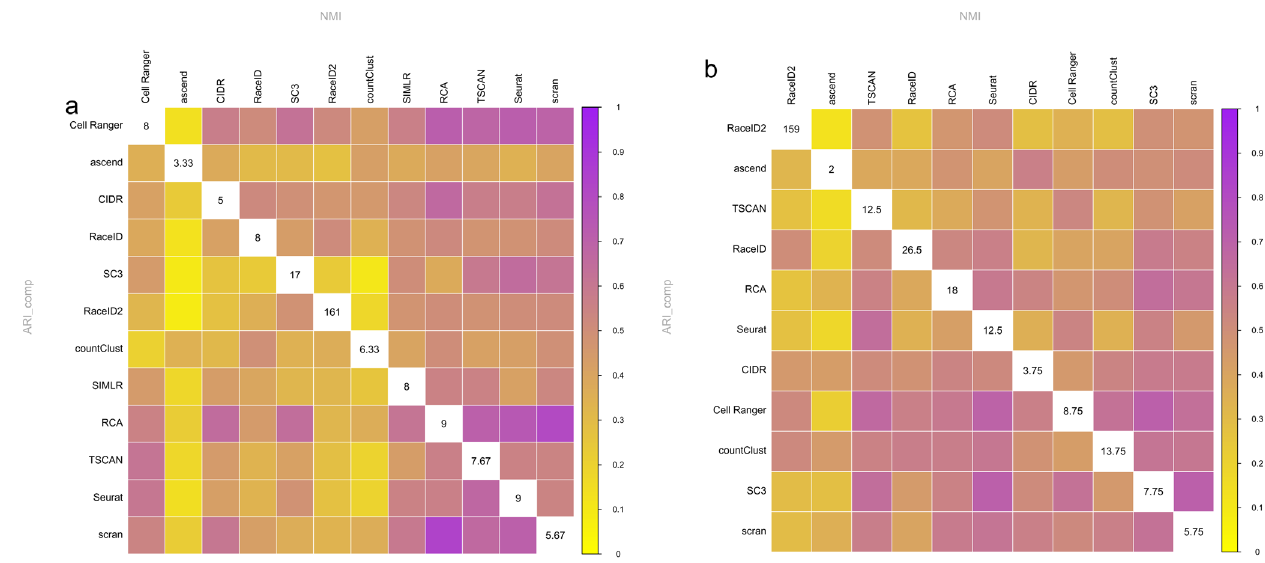
Figure 4. Similarity of all combinations of clustering methods as estimated by ARI_comp (lower triangle) and NMI (upper triangle) averaged over all datasets in ( a ) evaluation 1 (R version 3.4.3) and ( b ) evaluation 2 (R version 3.5.0). The similarity is indicated by the color; yellow indicating no similarity and purple indicating complete overlap. The diagonals give the average number of clusters estimated by each respective method. Note that methods are ordered according to similarity.